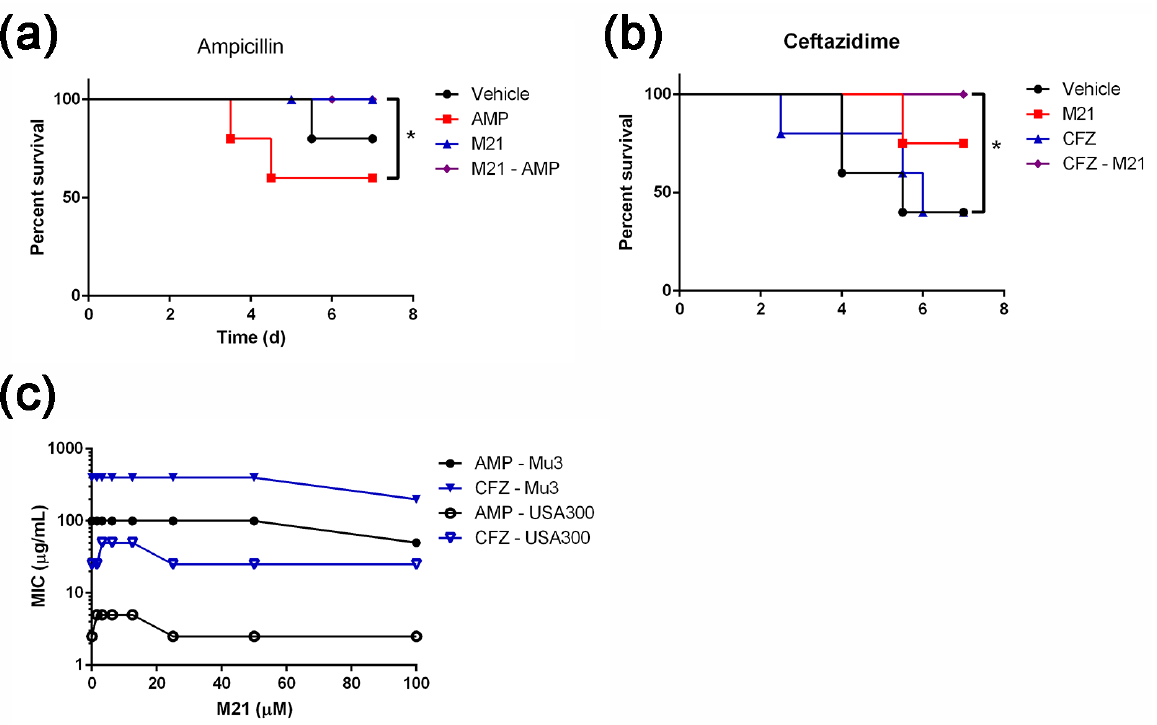
Figure 3. Combination of M21 with ampicillin or ceftazidime increased mice survival. ( a ) Ampicillin combined with M21 improved the survival of mice suggesting diminished antibiotic-induced viru- lence in S. aureus (MIC of M21 to Mu3 is higher than 500 µM). ( b ) Ceftazidime combined with M21 saved mice from antibiotic-induced S. aureus virulence. ( c ) No synergistic effect was detected among M21 and ampicillin, or ceftazidime against USA300 and Mu3 strains. Log-rank (Mantel–Cox) test was used for survival analysis and the treated groups were compared with the control group. Data represent mean values ± SEM (* p < 0.05 ) .